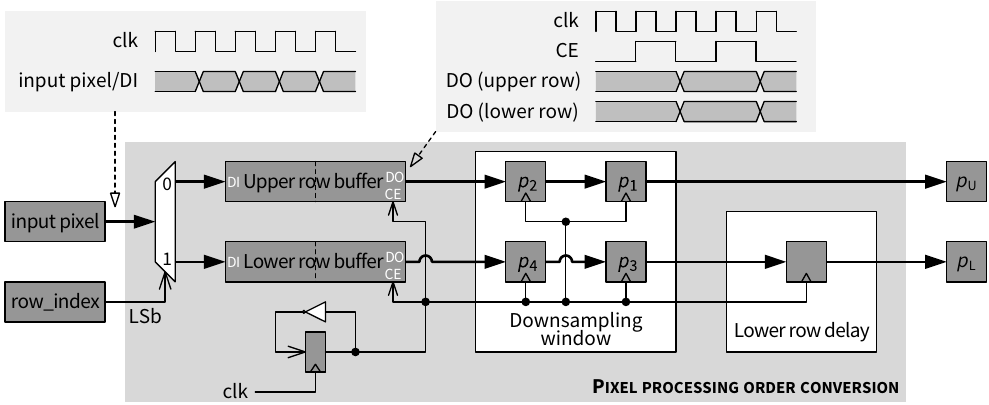
Figure 20. Pixel processing order conversion